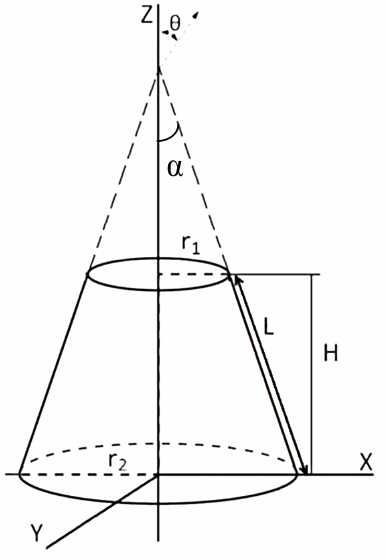
Figure 7. Geometry for the RCS calculation of the mast.